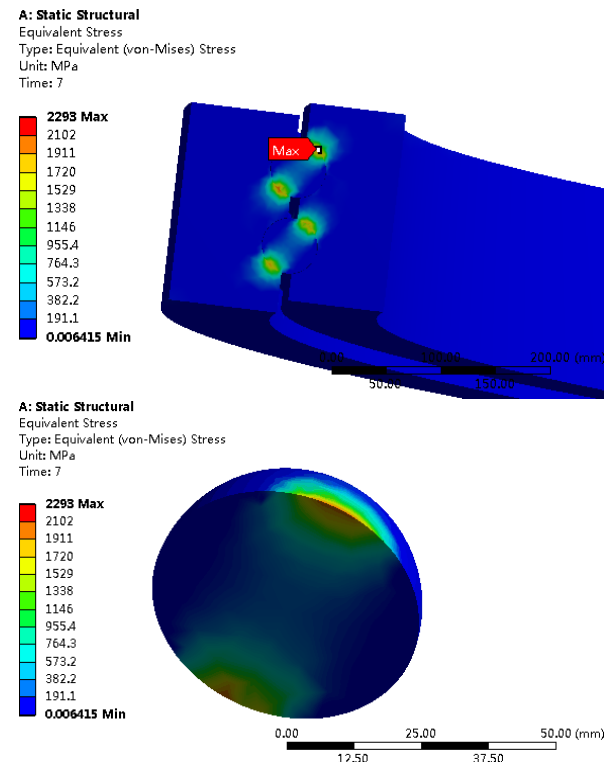
Figure 15: Slewing bearing mesh